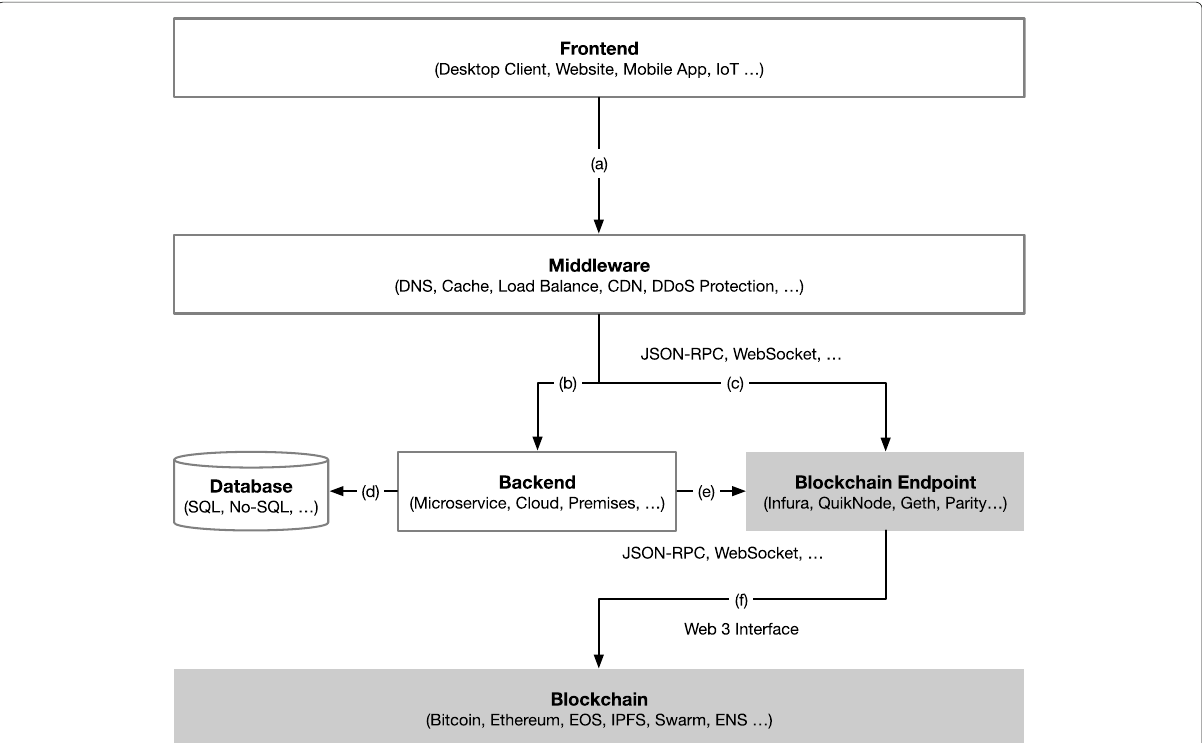
Fig. 2 A typical architecture of a blockchain-based cloud